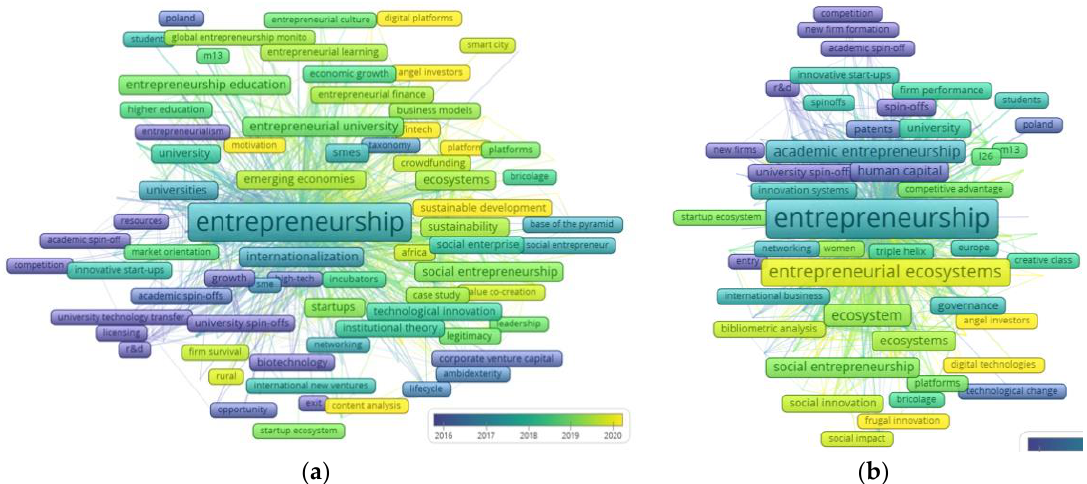
Figure 5. Co-occurrence analysis of authors’ keywords (VOSviewer). ( a ) Horizontal rotation; ( b ) vertical rotation.